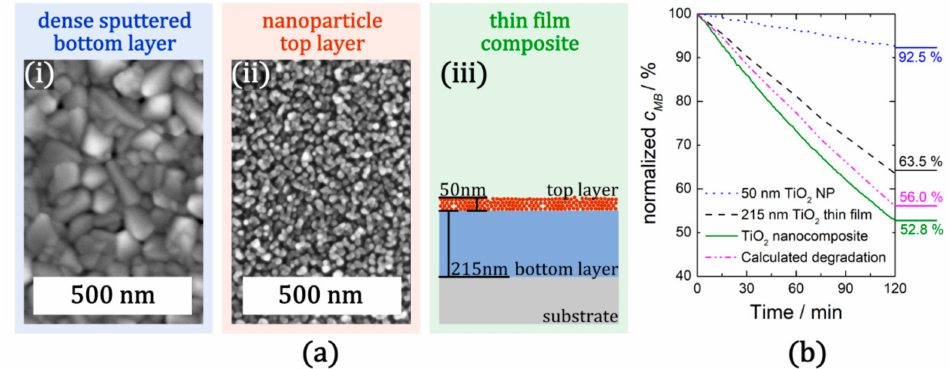
Figure 3. TiO 2 NPs / TiO 2 nanocomposites for enhanced photocatalytic performance: ( a ) SEM top view micrographs of the composite layers (i: bottom layer; ii: top layer) and schematic cross